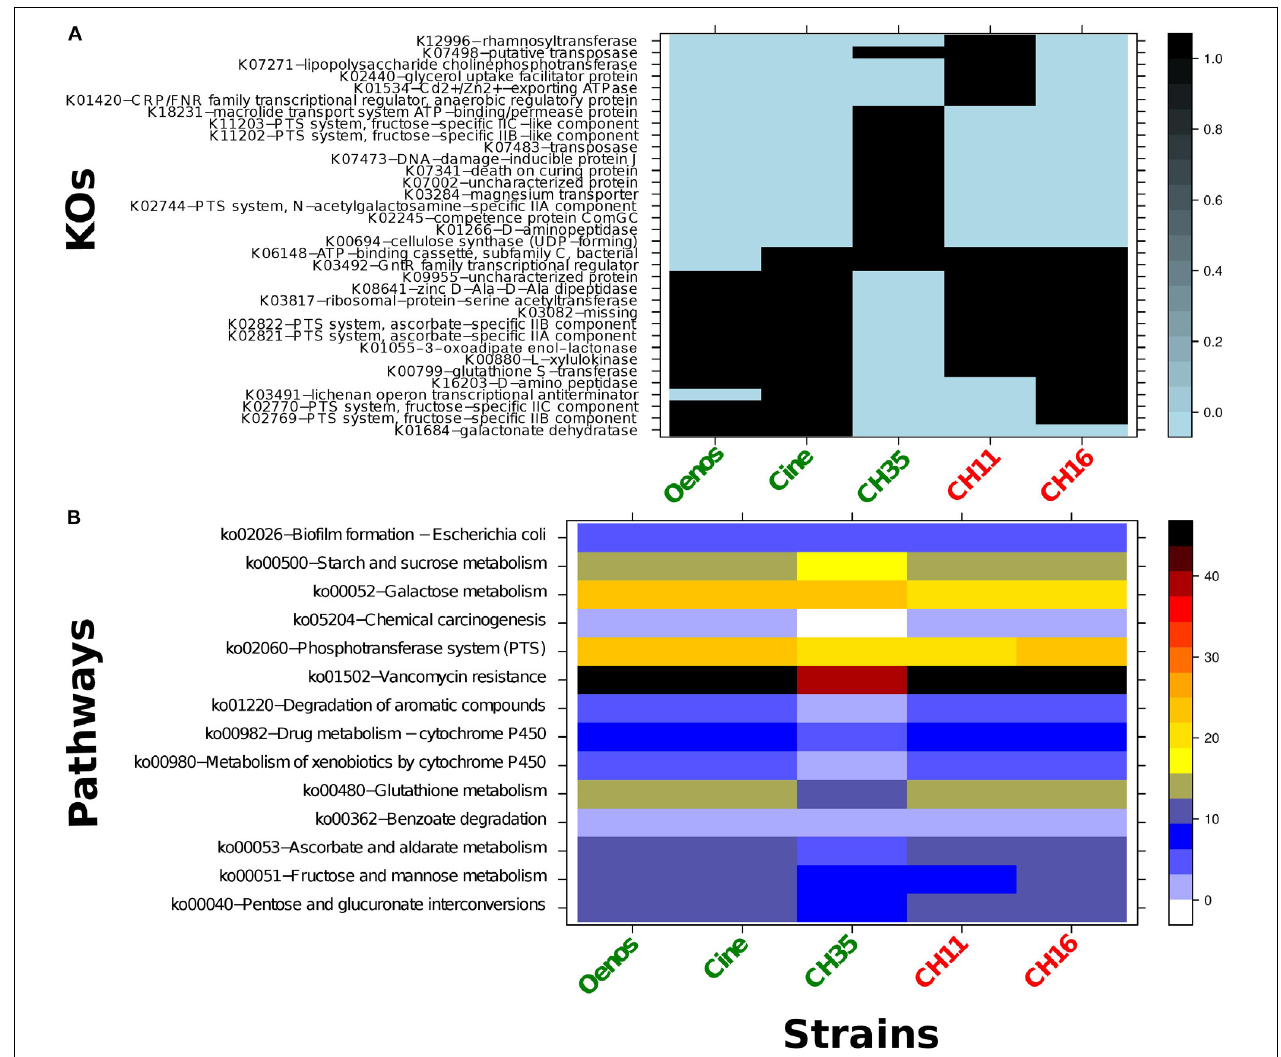
FIGURE 3 | (A) Heatmap representing the distribution of the 34 different KOs within the five O. oeni strains. Black - presence of the KO; light blue - absence of the KO; green - CE + strains and red - CE- strains. Row-names correspond to the KO identifiers and the corresponding KO definition. (B) Heatmap of the KEGG pathways enrichment within the five O. oeni strains. In right side the color scheme represents the pathway coverage which is the percentage of the KOs mapping the pathway divided by the total KOs number for the corresponding